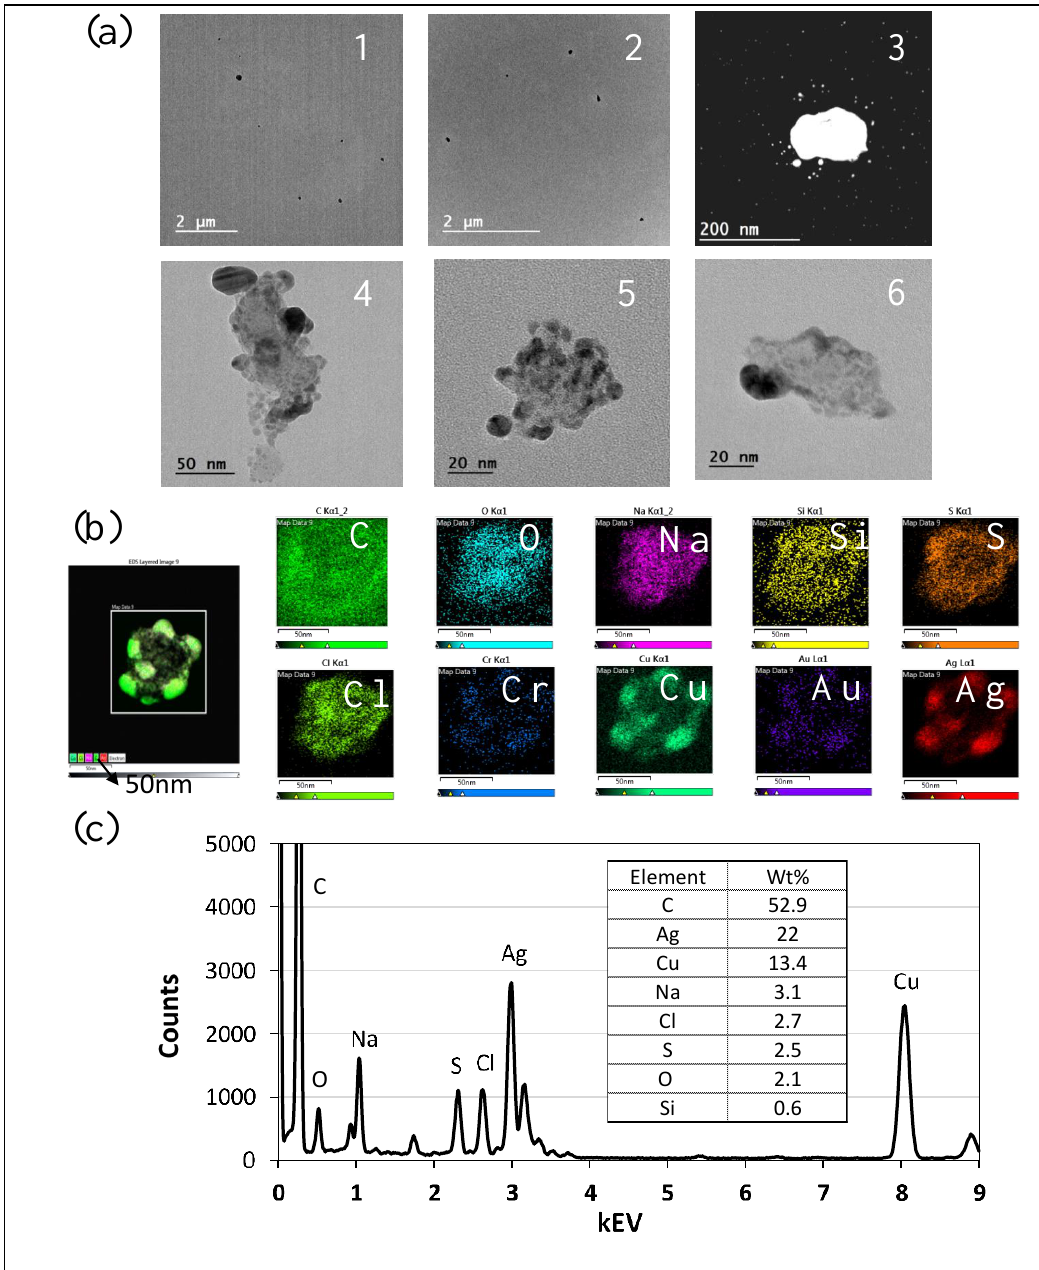
Figure 8. TEM and EDS analyses of particles from STS aerosolization. ( a ) TEM images of particles collected on a TDS copper grid from aerosolized STS, organized from low to high magnification and ranging in size from less than 20 nm to greater than 1 µ m. ( b ) Elemental maps of the particle used for EDS analysis. The scale bar is 50 nm. The particle contains the elements carbon (C), oxygen (O), sodium (Na), silicon (Si), sulfur (S), chlorine (Cl), chromium (Cr), copper (Cu), silver (Ag), and gold (Au), from left to right, all with a scale bar of 50 nm. ( c ) EDS analysis of particle in image ( b ). Note: Images 1 and 2 with low magnification present overviews of the collected samples showing no large particles observed. Images 3 to 6 clearly present nanoparticles observed with high magnification.